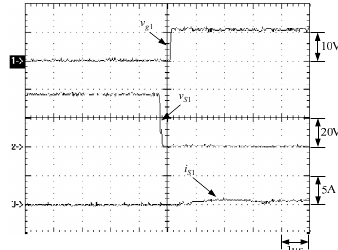
Figure 19. Waveforms pertaining to S 1 at the minimum load: (1) v g 1 ; (2) v S 1 ; and (3) i S 1 .